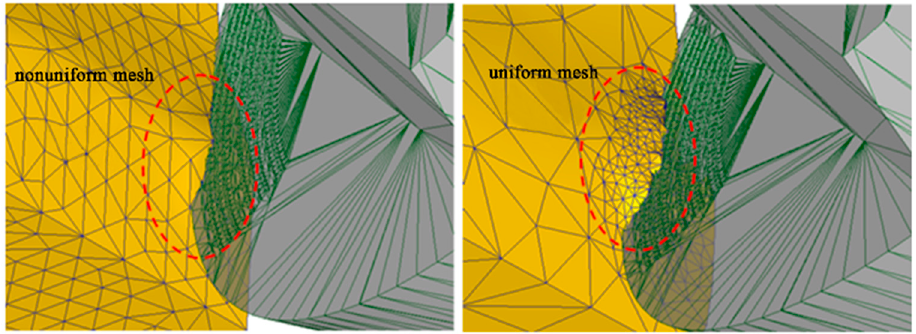
Figure 3. Adaptive mesh generation.